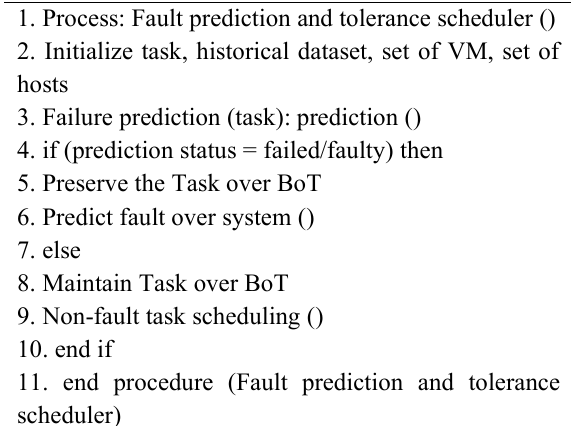
Algorithm 1: Prediction of fault and